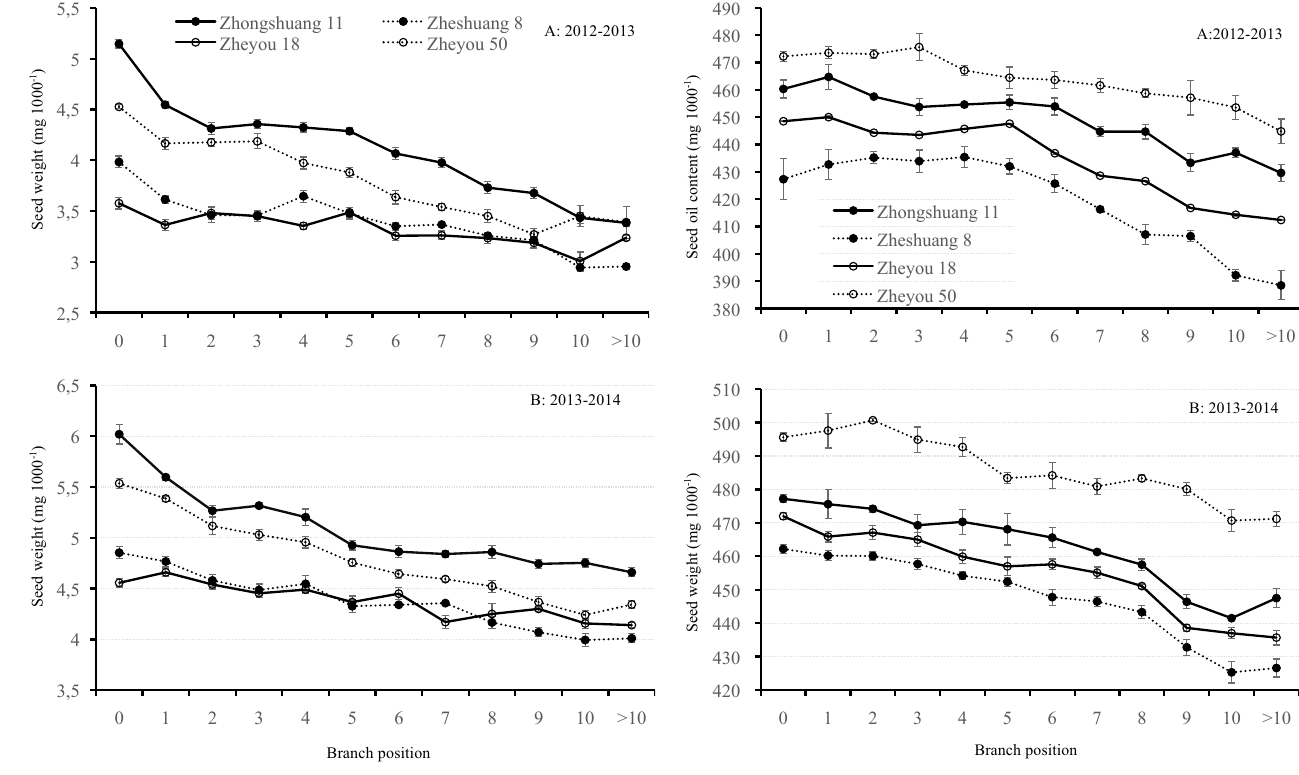
Fig. 1: Seed weight in the main inflorescence and different branches from the top to the bottom of the main stem in the four cultivars, Zheyou 50, Zhongshuang 11, Zheyou 18, and Zheshuang 8 in (A) 2012-2013 and (B) 2013-2014 growth seasons.